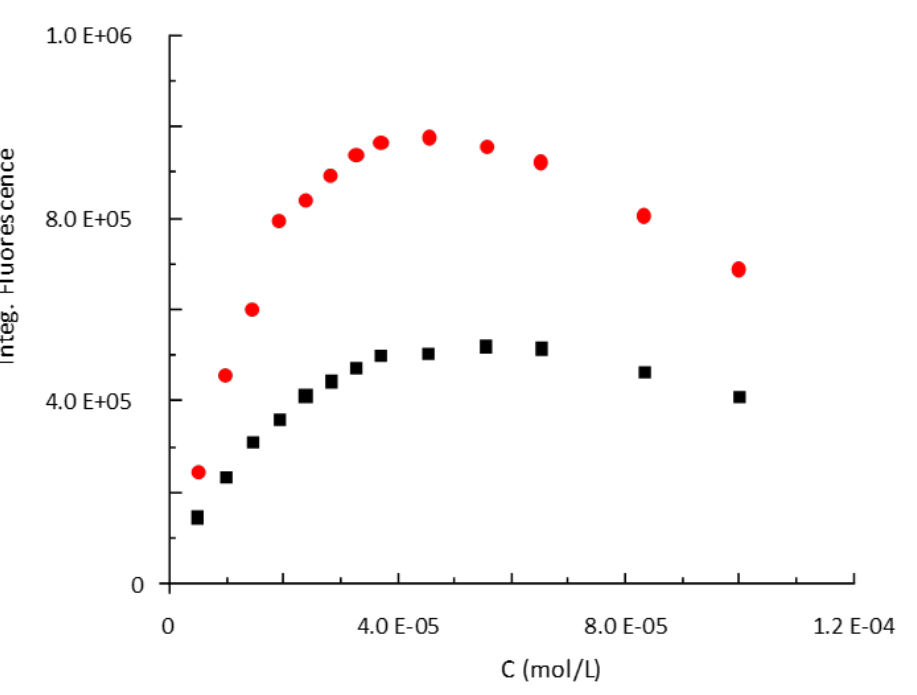
Figure 6. Integrated fluorescence intensity of P797 in its reduced (black marks, A ) and oxidized (red marks, B ) forms as a function of its concentration in acetonitrile+ TBABF 4 0.1 mol.dm −3 .